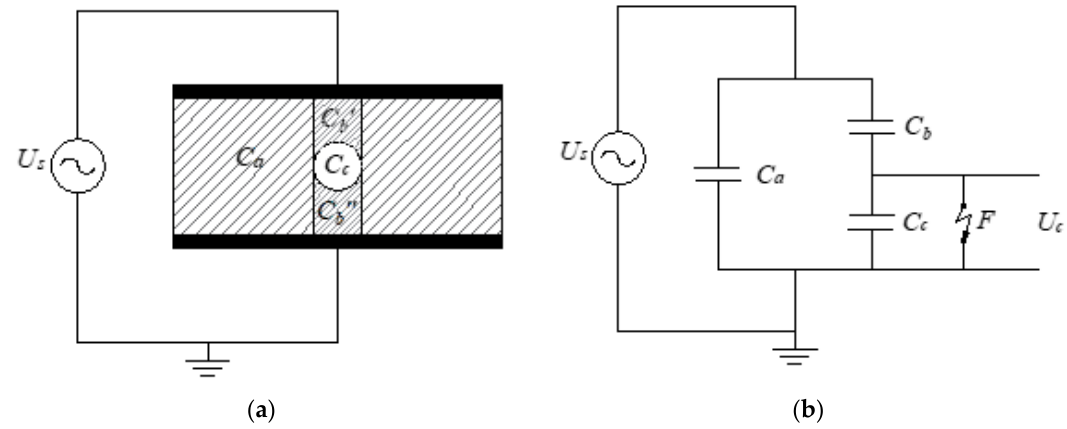
Figure 3. Whitehead three-capacitance model: ( a ) bulk of dielectric material with a spherical void and capacitances of components in series and parallel with the void; ( b ) “abc” equivalent circuit, F is the spark-gap representing the PD event.